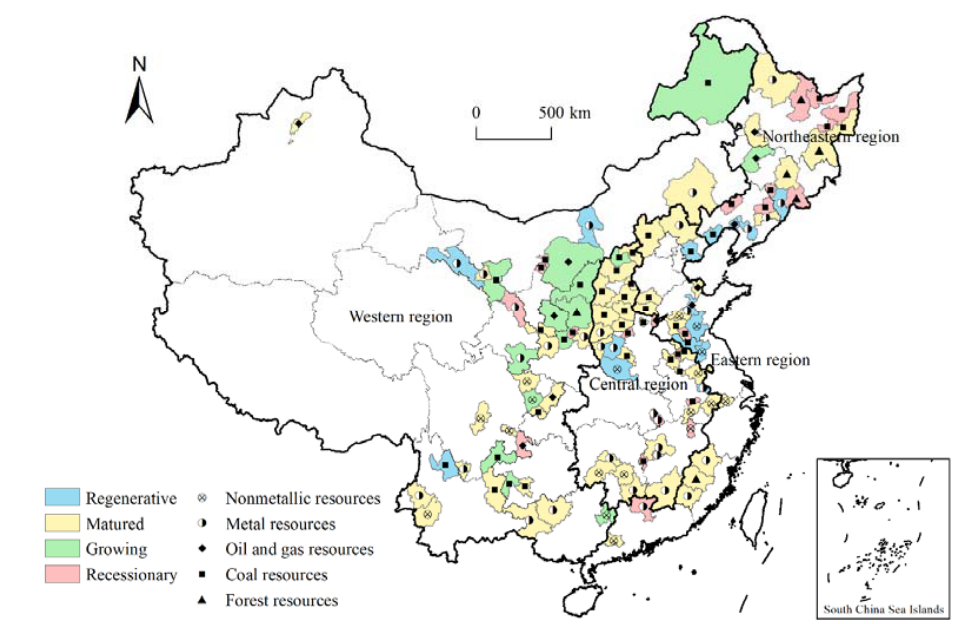
Figure 2. Spatial distribution of resource ‐ based cities in China.